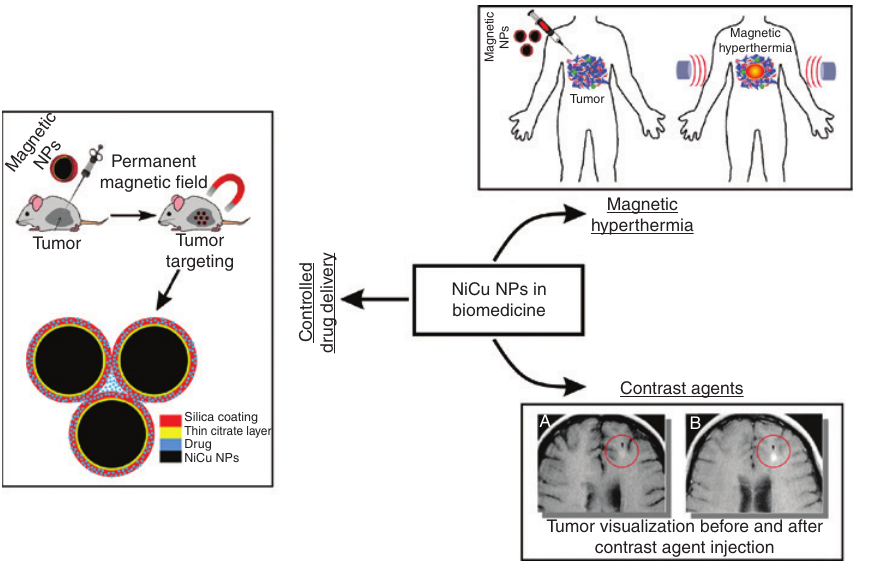
Figure 1: Various applications of MNPs for drug delivery as contrast agent and for magnetic hyperthermia. Left: Incorporation of drugs into coatings on MNPs enables tumor targeting using the magnetic field. Upper right: MNPs can be injected into the tumor, followed by application of an AMF, which results in magnetic hyperthermia. Bottom right: MNPs can be also used as potent and relatively cheap contrast